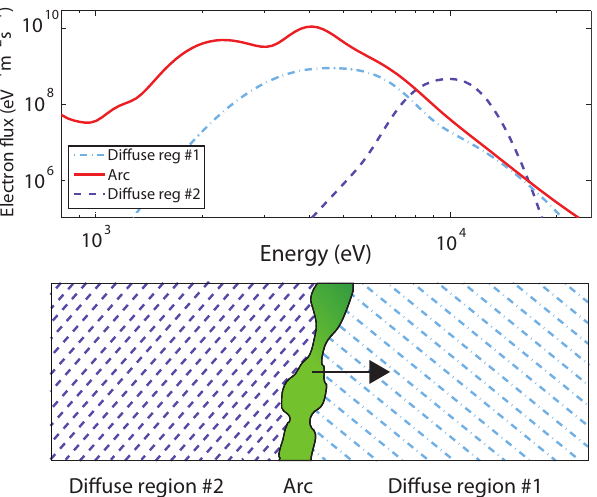
Fig. 10. Top: energy vs electron number flux derived from the in- version model, for the regions to the west of the arc (region 1), in Fig. 10. Top: Energy vs electron number flux derived from the in- Fig. 10. Top: Energy vs electron number flux derived from the in- the arc and to the east of the arc (region 2). Bottom: illustration of version model, for the regions to the west of the arc (region 1), in version model, for the regions to the west of the arc (region 1), in the 1932 arc and the two regions of different average energy sur- the arc and to the east of the arc (region 2). Bottom: Illustration of the arc and to the east of the arc (region 2). Bottom: Illustration of rounding the 1932 arc and the two regions of different average energy sur- the 1932 arc and the two regions of different average energy sur- rounding it. rounding it.